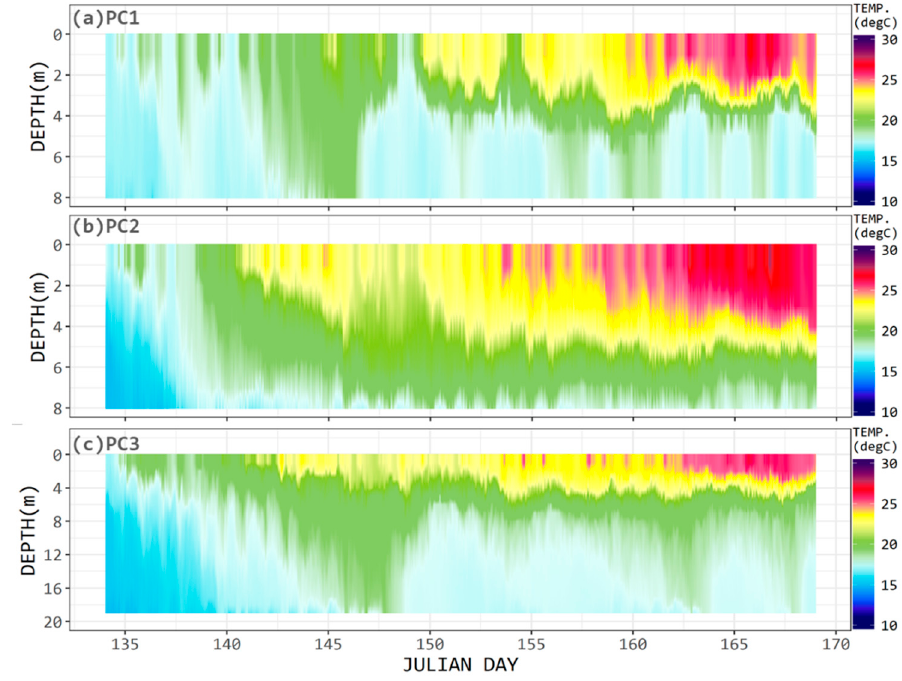
Figure 4. Observed time-depth profiles of water temperature at ( a ) PC1, ( b ) PC2, and ( c ) PC3. Julian day indicates the day of the year 2016, the temperature unit is °C, and the depth is measured from the water surface level.